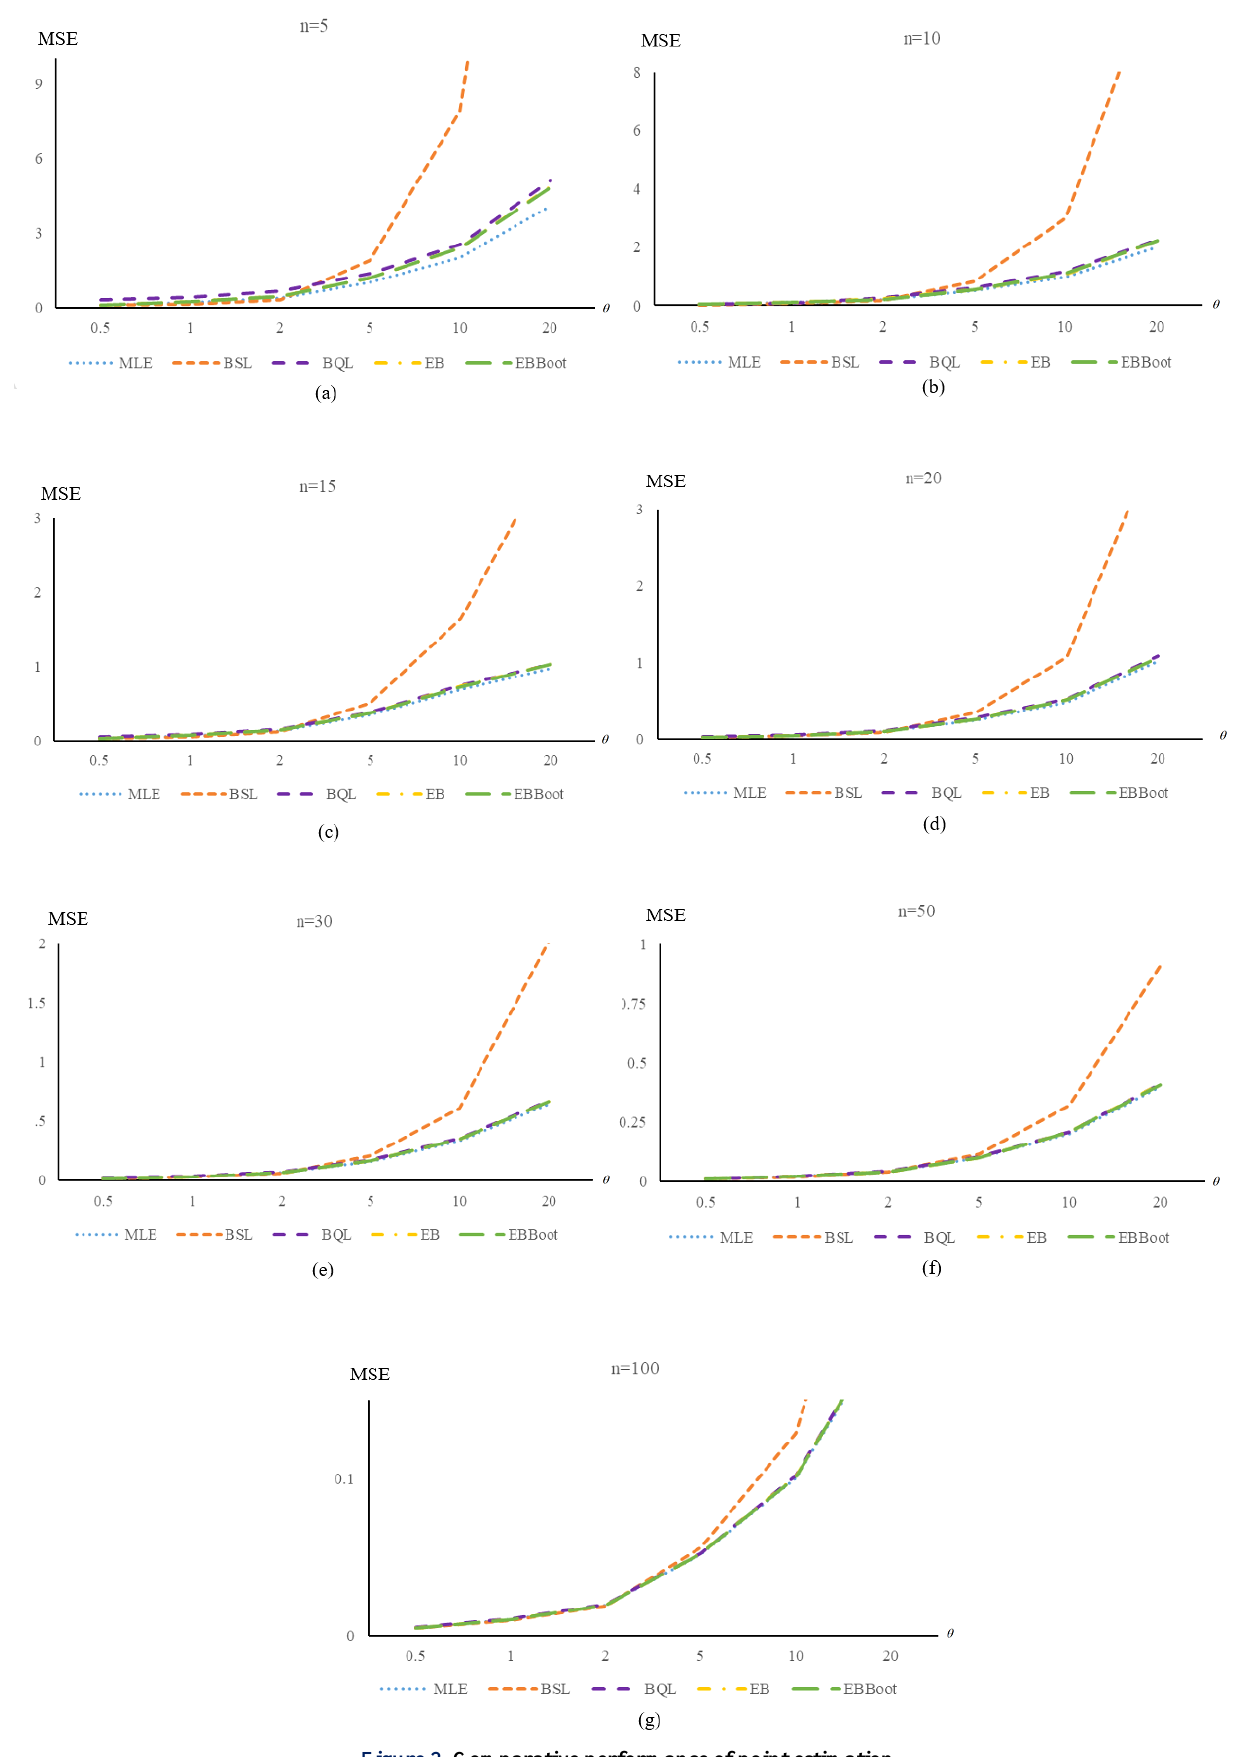
Figure 2. Comparative performance of point